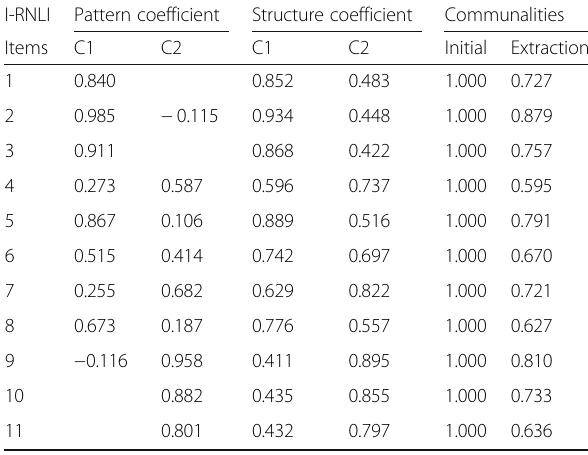
Table 6 Pattern and structural matrix for PCA with Oblimin rotation of two-factor solution of the I-RNLI items I-RNLI Pattern